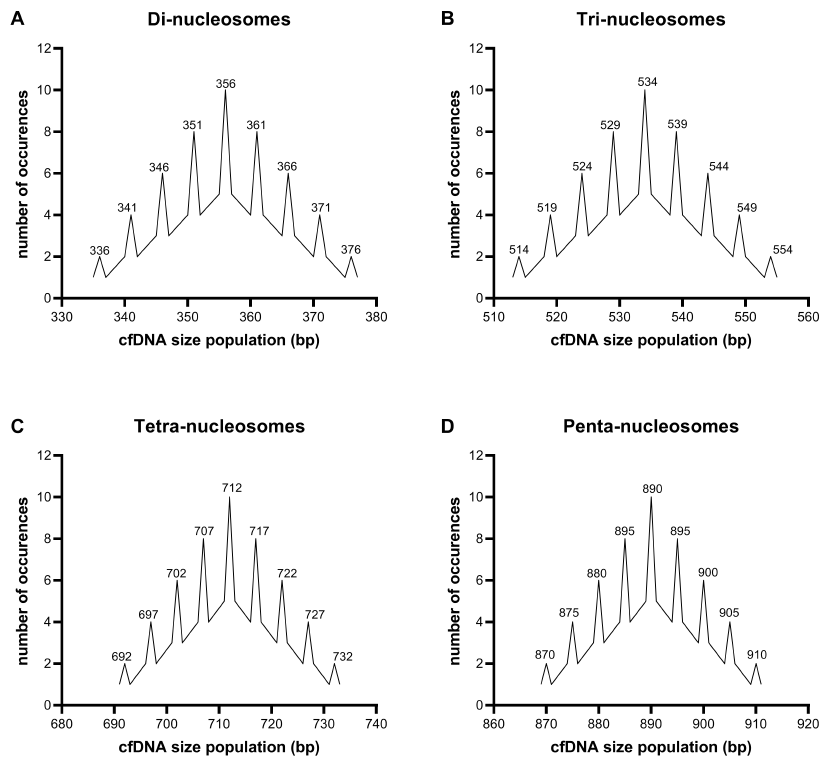
Figure 4. Theoretical cell-free DNA (cfDNA) fragmentation profiles. Here, we calculated the relative proportion of different ( A ) di-nucleosomal, ( B ) tri-nucleosomal, ( C ) tetra-nucleosomal and ( D ) penta- nucleosomal size populations that can theoretically form when oligo-nucleosomes with an average linker DNA length of 31 bp have an equal probability of being digested 5, 6, 10, 11, 15 and 16 bp up- or downstream from a 147 bp nucleosome core particle